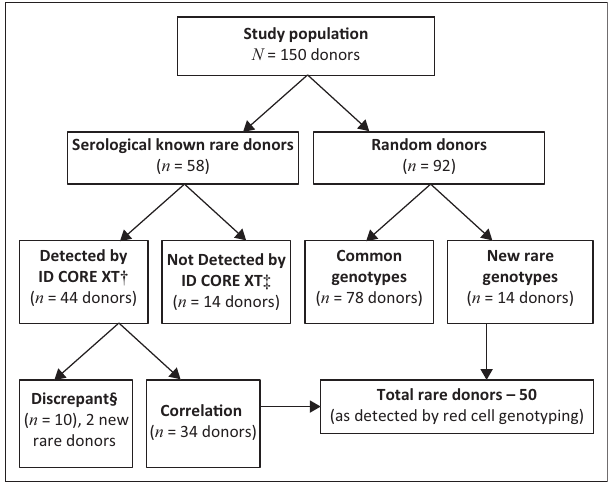
FIGURE 1: Breakdown of the study population and the resultant total of 50 genetically identified donors based on retrospective red cell genotyping obtained from the South African National Blood Service, Immunohaematology Reference Laboratory over the period January 2015 – August